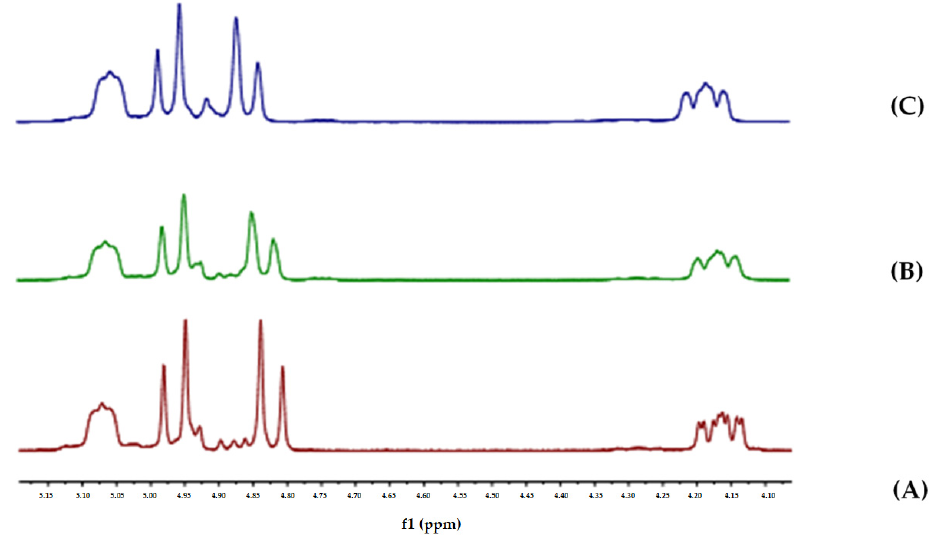
Figure 5. Selected 1 H-NMR spectral region of compound 16 before and following the addition of base. ( A ) Compound 16 ; ( B ) compound 16 and 2 equiv. of proton sponge after 10 min; ( C ) compound 16 and 2 equiv. of proton sponge after 24 h.